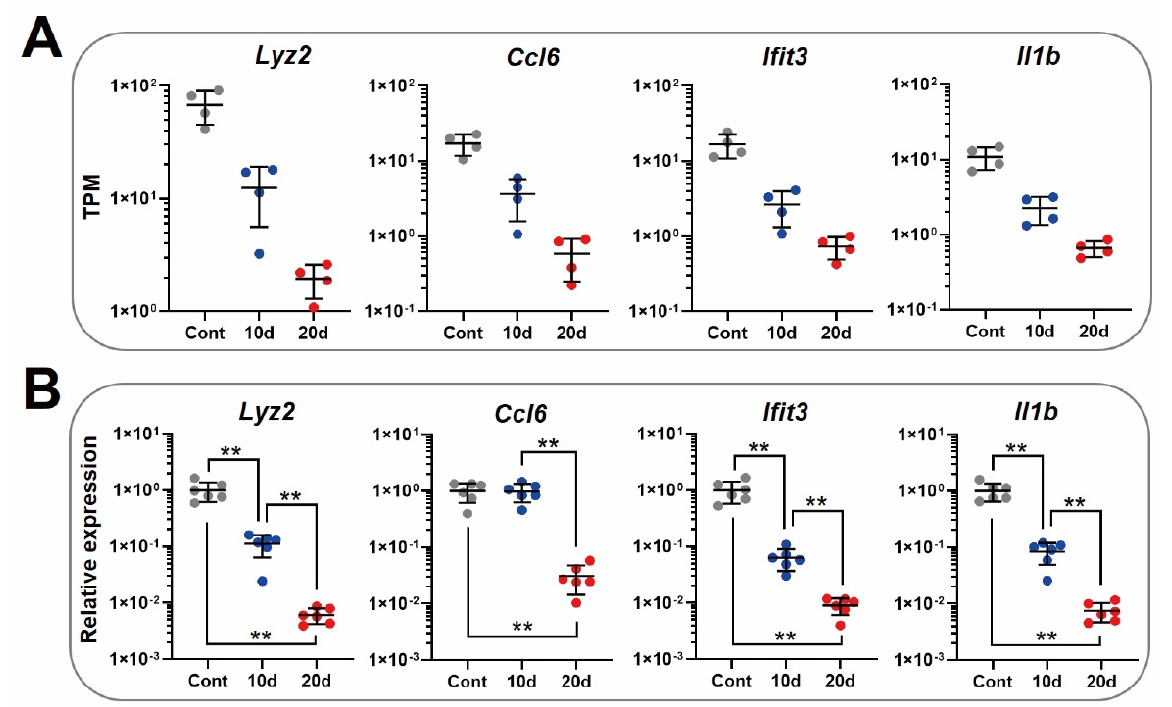
Figure 5. Confirmations of reproducibility using the qPCR assay. ( A ) Plot graphs of the TPM values from the RNA-Seq. ( B ) Plot graphs of the relative expression values from the qPCR assay. ** p < 0.01.